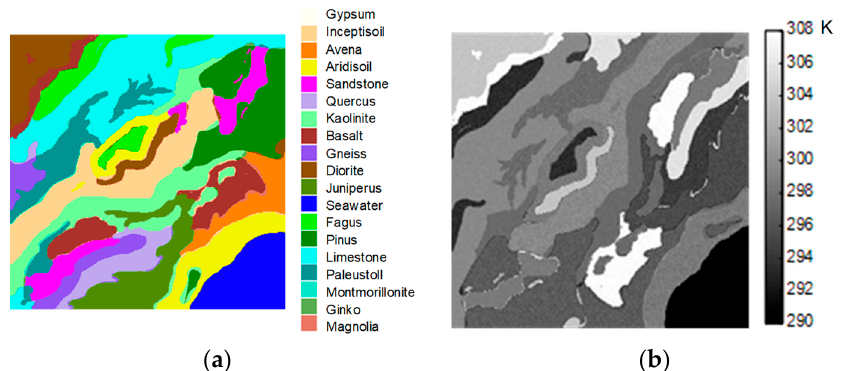
Figure 1. HyspIRI-like simulated image: ( a ) thematic map with 19 classes; ( b ) Simulated ground-truth temperature image.